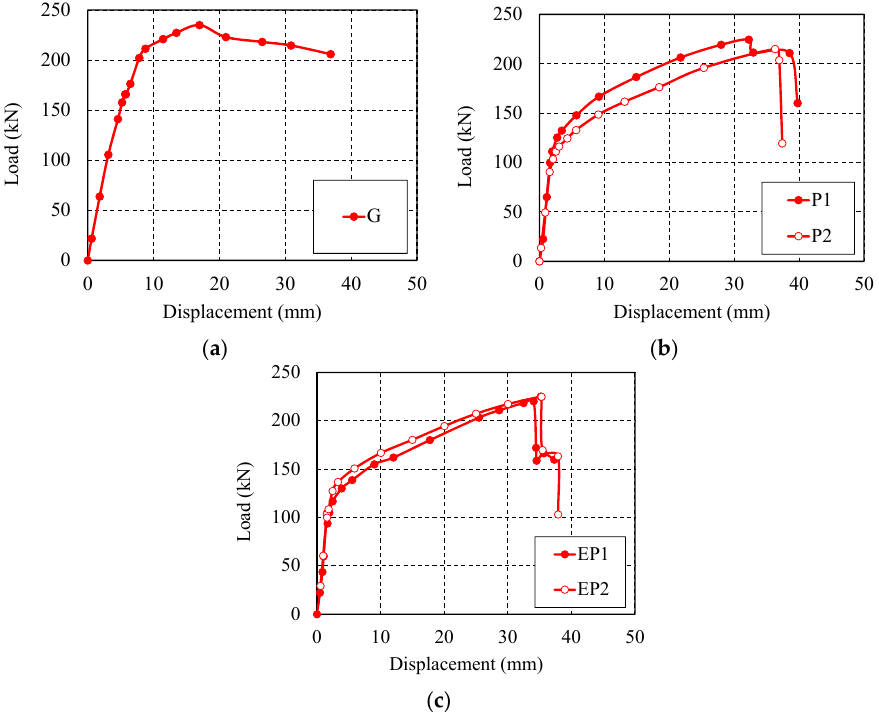
Figure 14. Load-deflection curves; ( a ) G; ( b ) P series; and ( c ) EP series.